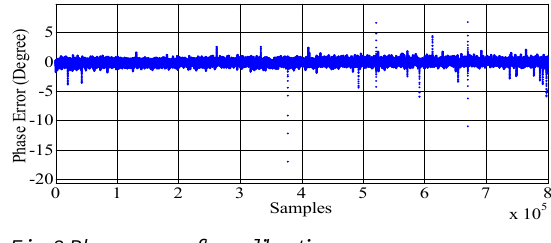
Fig. 8 Phase error after